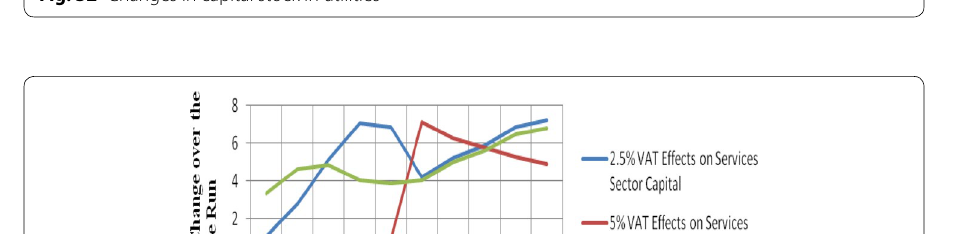
Fig. 32 Changes in capital stock in utilities